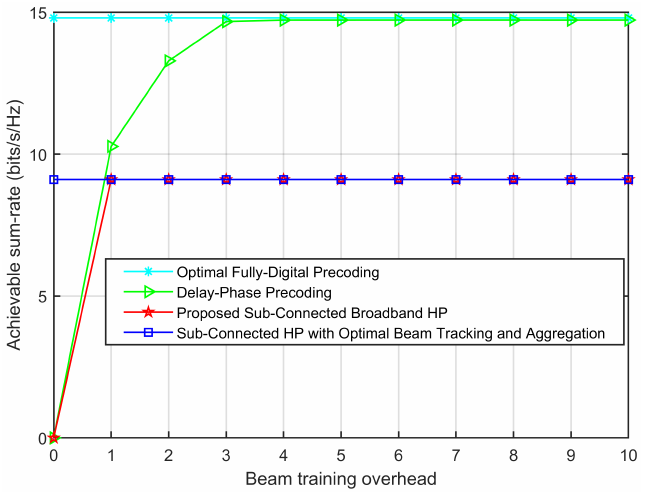
Figure 3. Effect of beam tracking on achievable sum-rate (SNR = 10